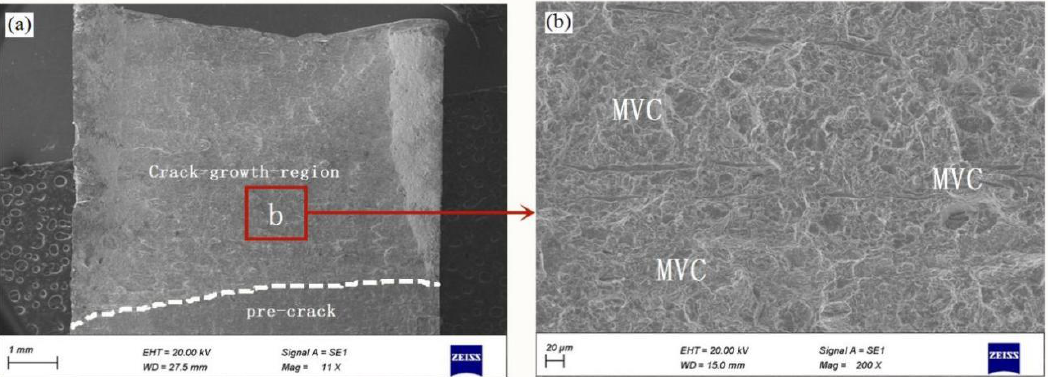
Figure 3. ( a ) Scanning electron microscopy (SEM) images for 45CrNiMoVA low alloy steel CT specimen, and ( b ) SEM high magnification image of the selected region in ( a ).